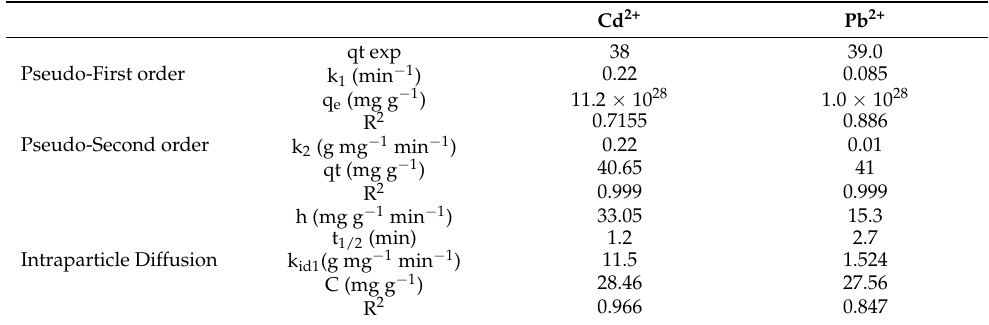
Figure 11. Pseudo-second-order equations for Cd 2+ and Pb 2+ using BPAC@Al 2 O 3 @chitosan. Table 3. Kinetics parameters for pseudo-first order, pseudo-second-order, and intra-particle diffu- sion.